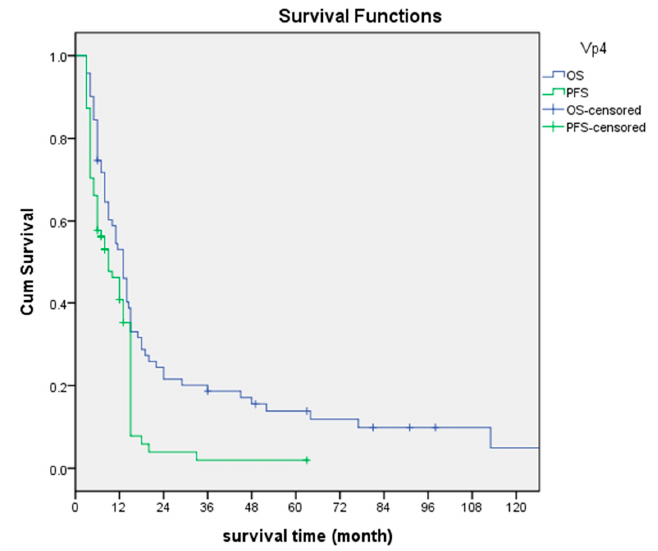
Figure 3. PFS and OS of all 71 Vp4